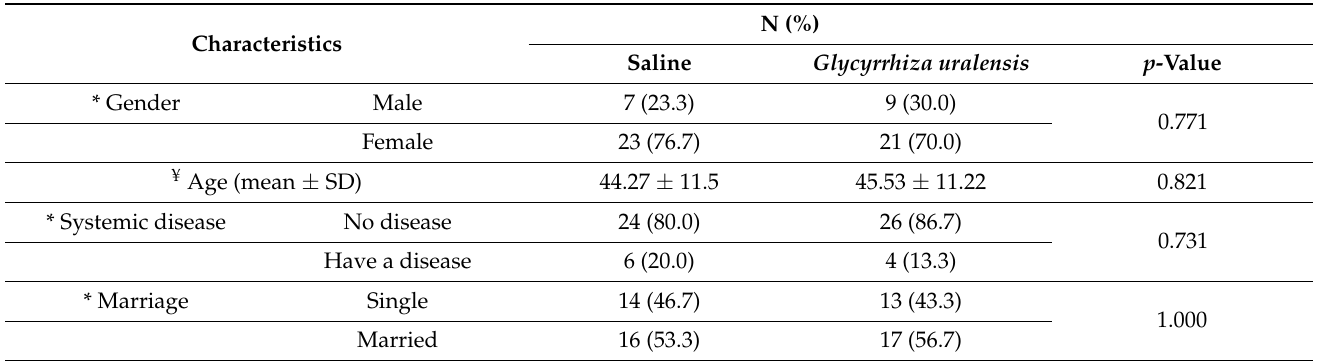
Table 2. Characteristics of the subjects in the two